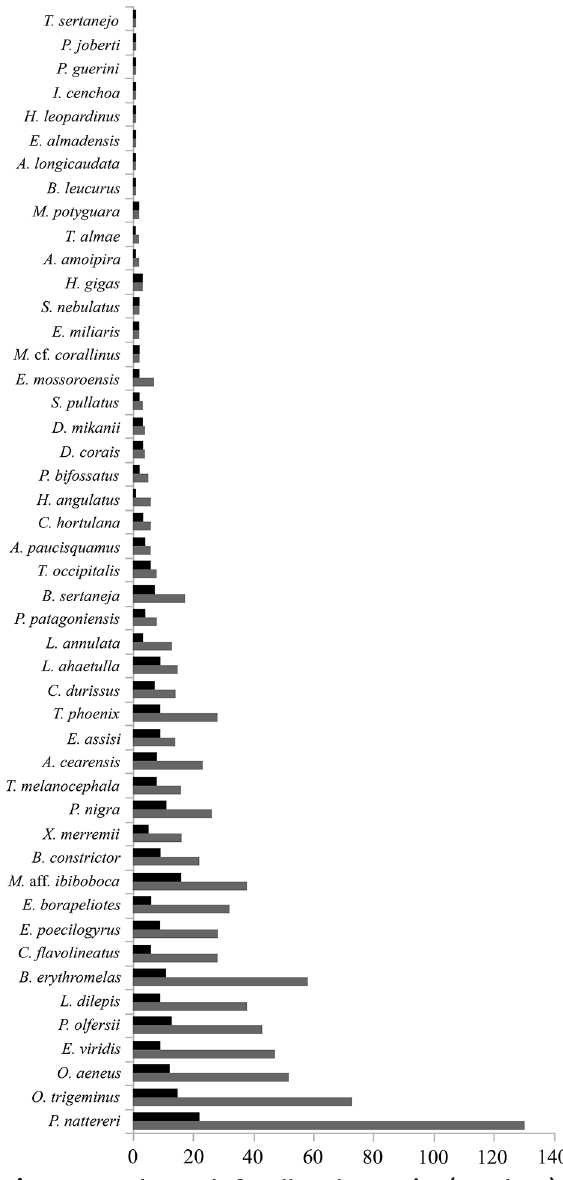
Figure 7. Total records for all snake species (gray bars) and total municipalities where they were recorded (black bars) in Rio Grande do Norte state,